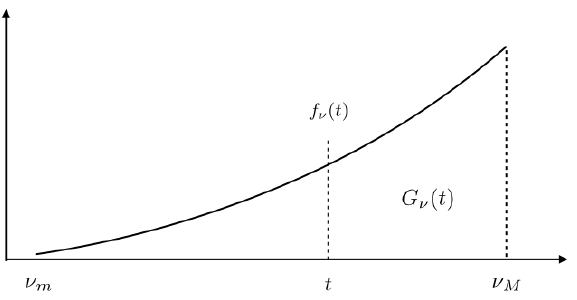
Figure 1. Rate request distribution f ν ( . ) for a regular circular